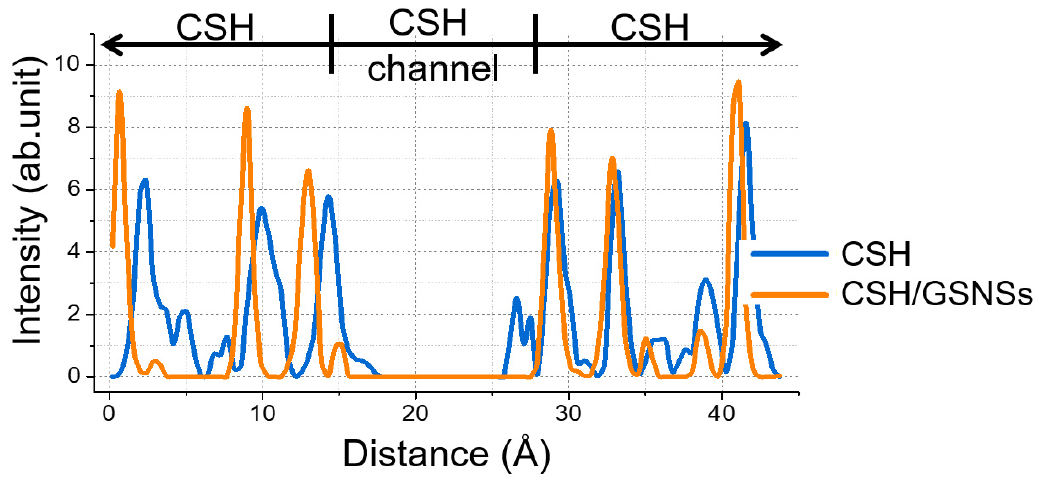
Figure 14. Atomic distribution of silicon along z direction.